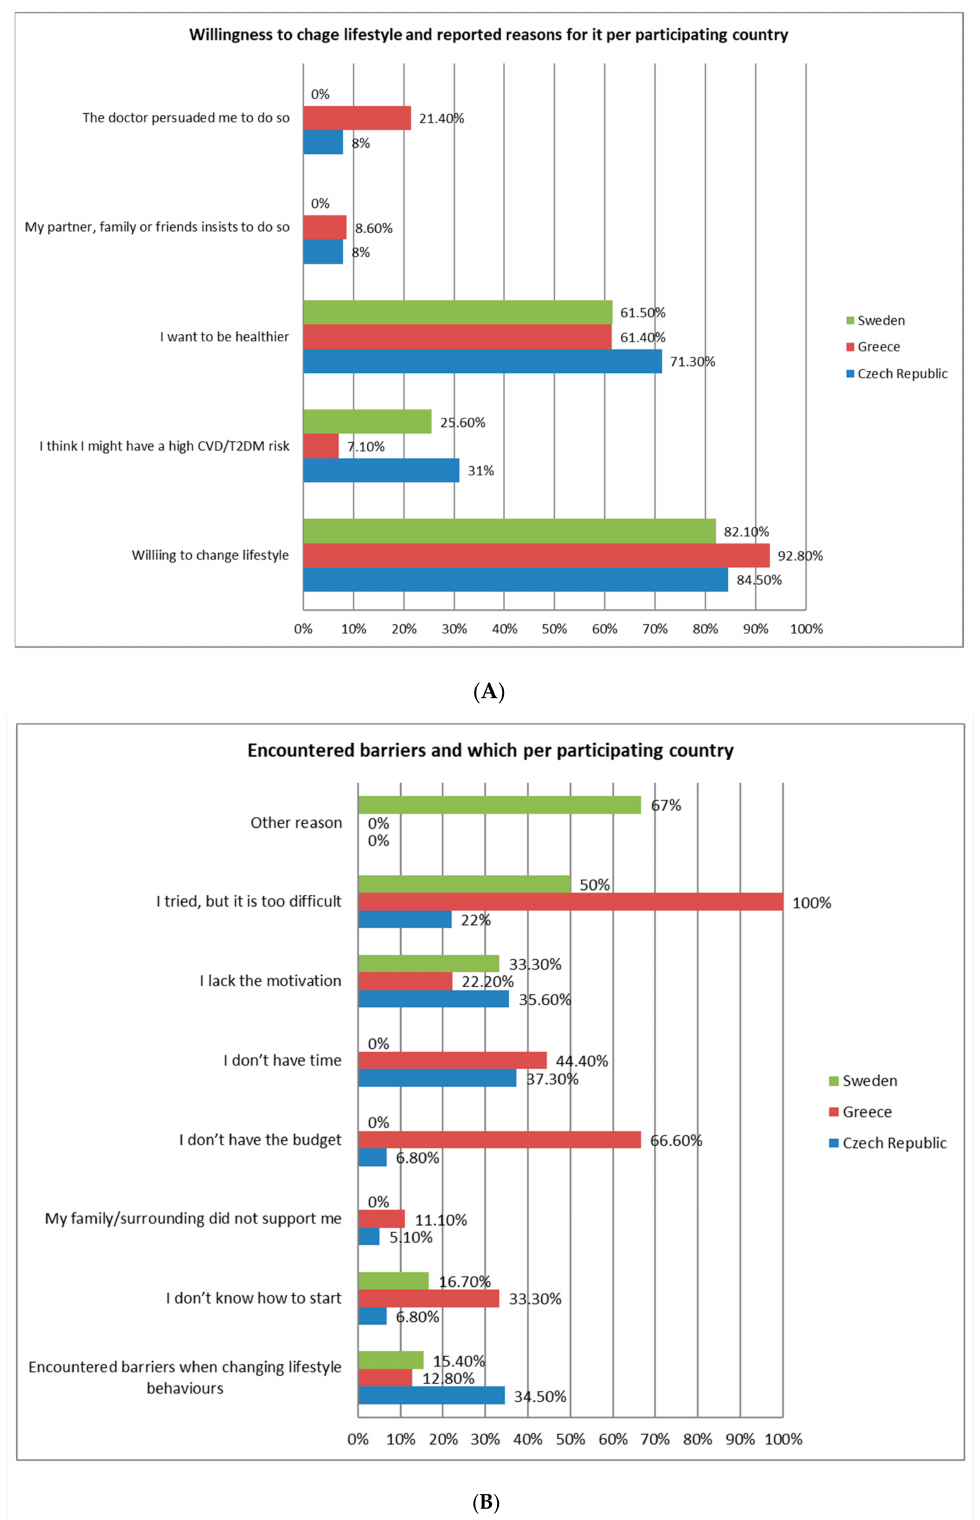
Figure 3. Willingness ( A ) and barriers ( B ) towards changing lifestyle among participants accepting risk assessment: (Despite invitation, participants from Denmark and the Netherlands did not answer evaluation questions). Abbreviations: CVD: cardiovascular disease, T2DM: type-II diabetes